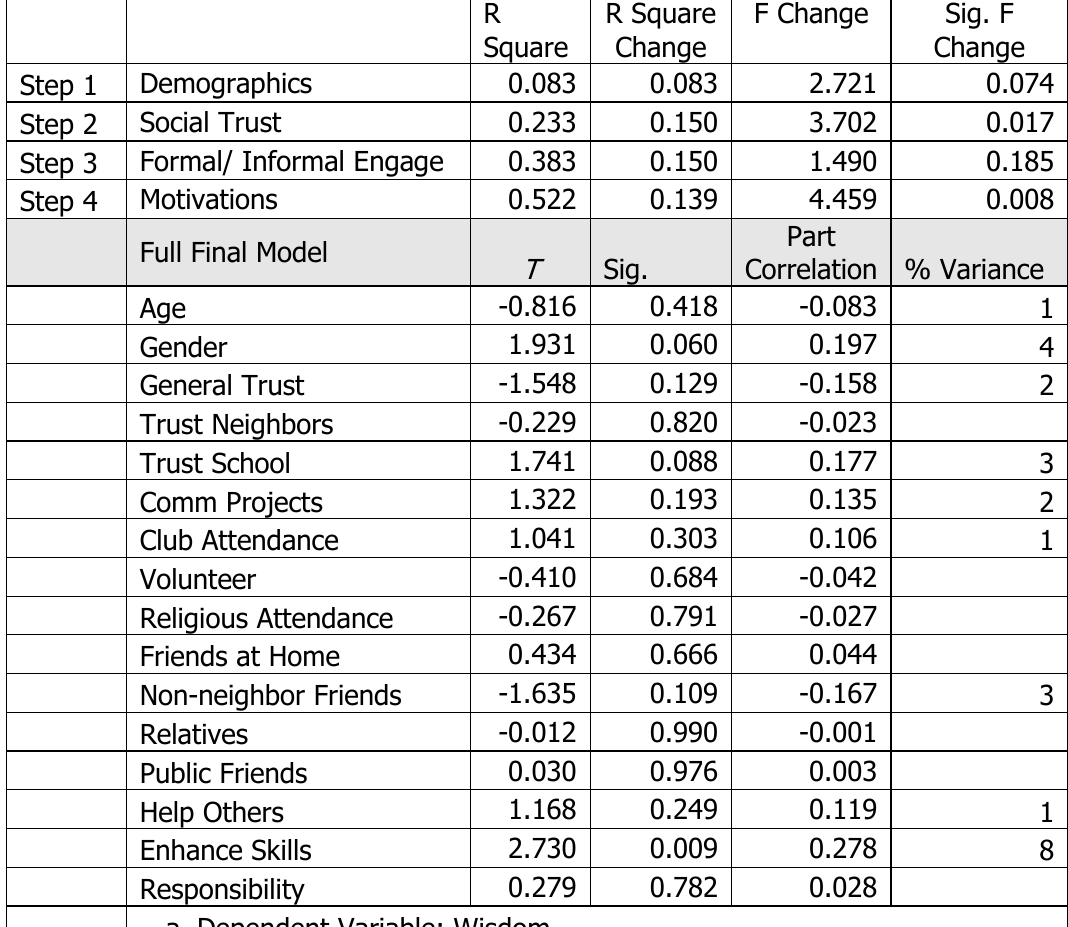
Four State Linear Regression Model to Predict Wisdom Scores